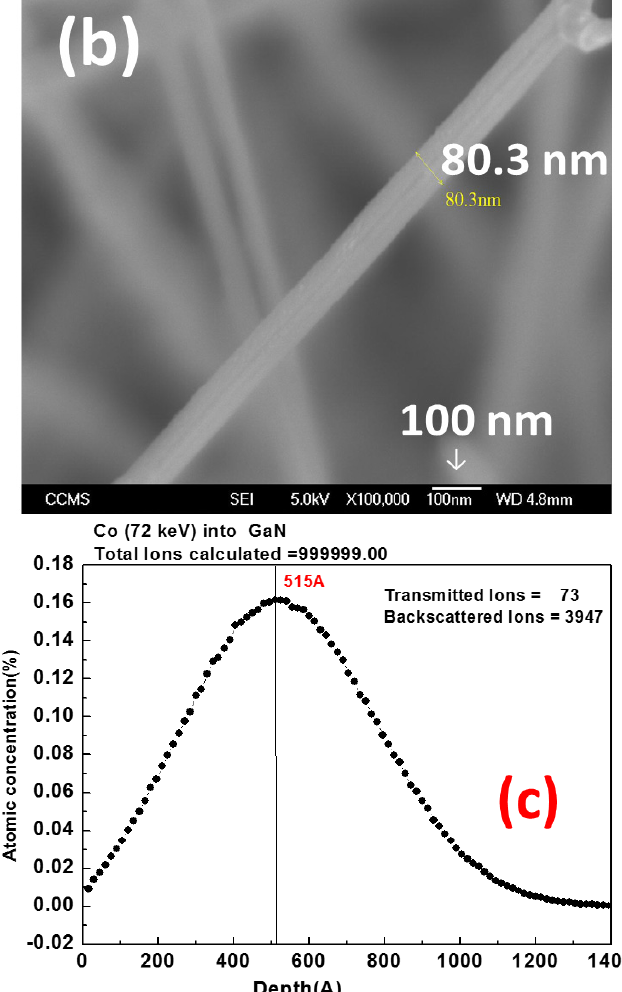
Figure 1. Morphology of as-grown GaN NWs: ( a ) ×10 K and ( b ) ×100 K, and ( c ) TRIM simulation for cobalt (72 keV)-doped GaN Nanowires with 1,000,000 atoms.